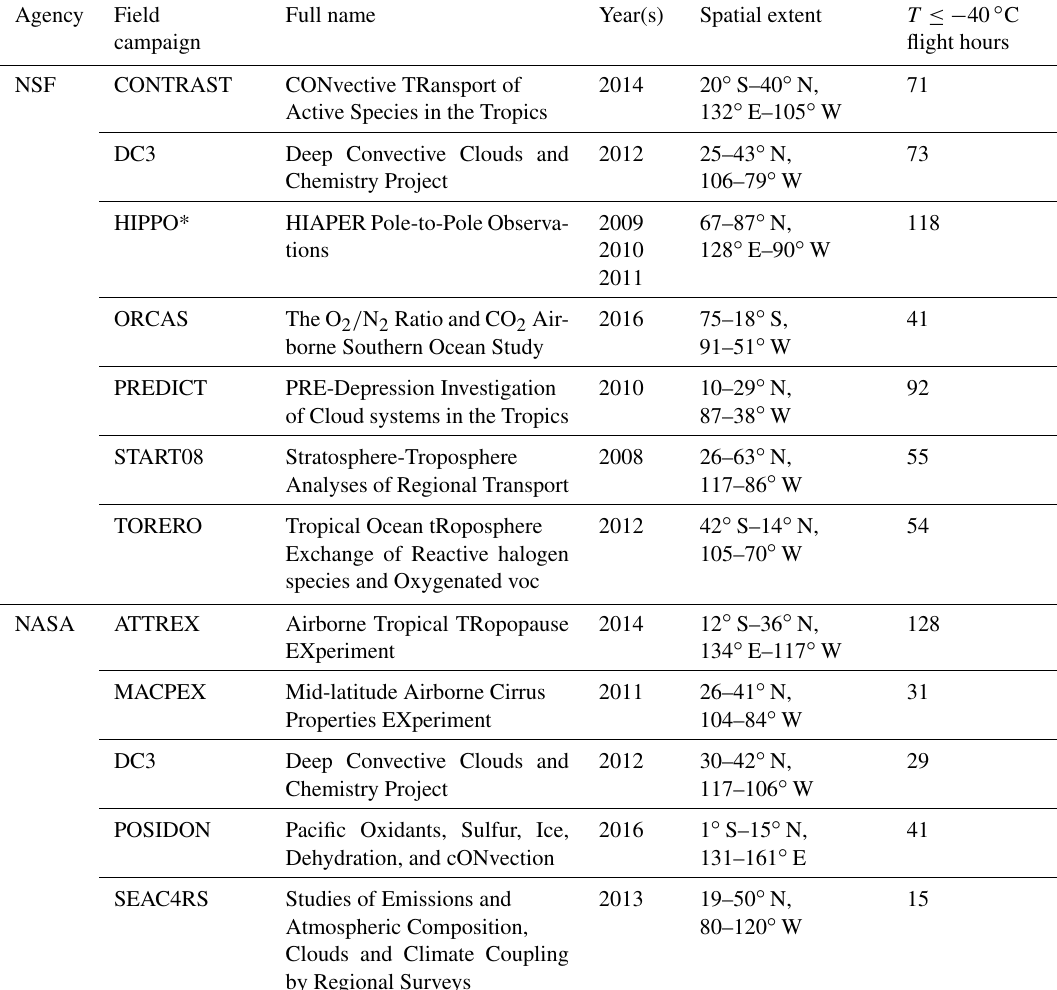
Table 1. A list of the funding agency, field campaign name, date and flight hours at temperatures ≤ − 40 ◦ C for the seven NSF research campaigns and five NASA campaigns used in this